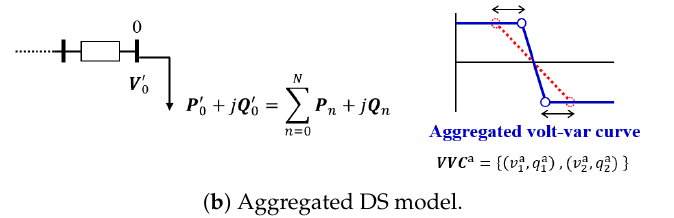
Figure 1. Schematic image of ( a ) original and ( b ) aggregated models. The proposed method aggre- gates an arbitrary bus (bus 0) and the other subsequent buses with active power and reactive power. Then, the volt-var curve for the aggregated bus is determined so that the voltage variations at bus 0 become similar.